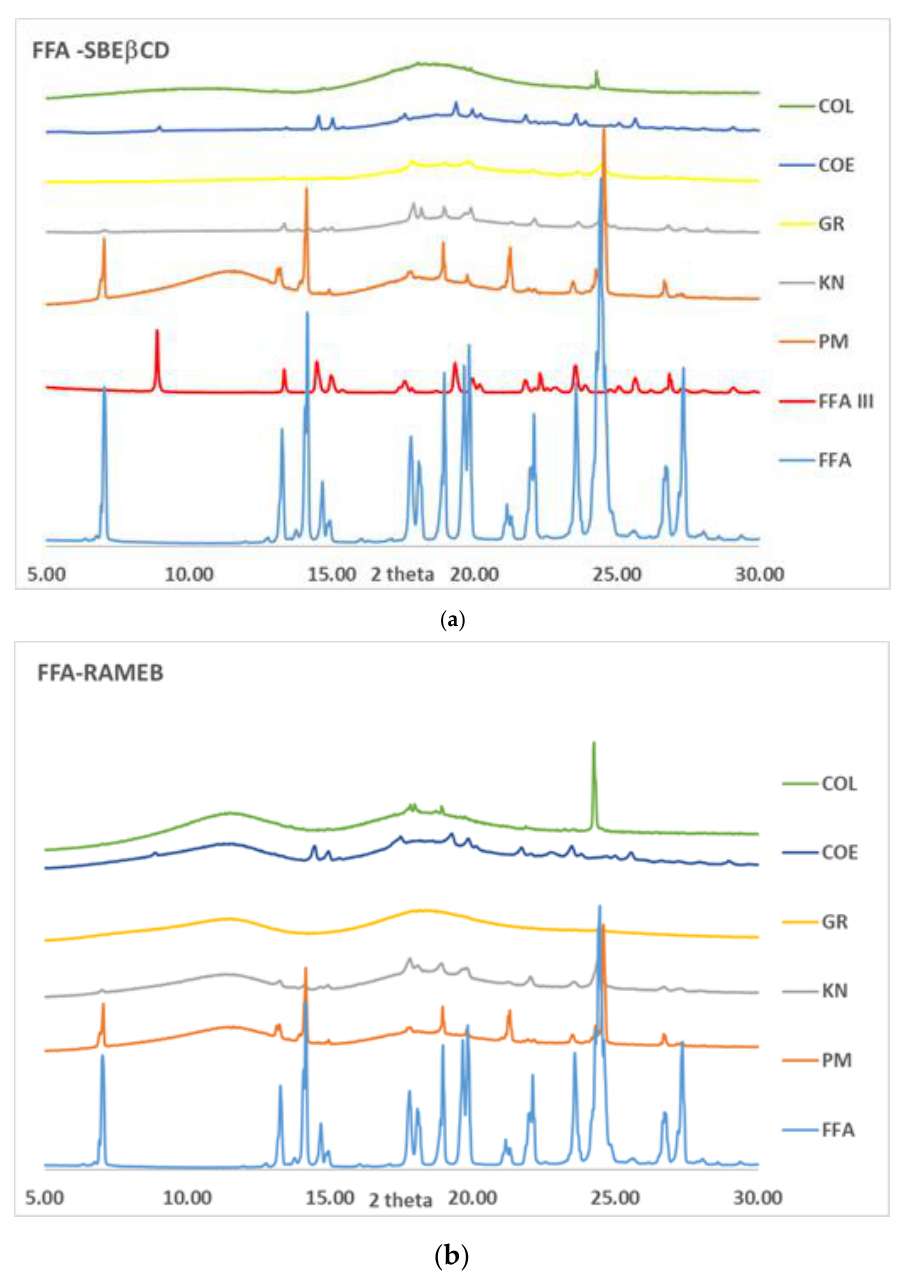
Figure 2. XRPD patterns of FFA binary systems with SBE β CD ( a ) and RAMEB ( b ) obtained by physical mixing (PM), kneading (KN), co-grinding (GR), co-evaporation (COE) and co-lyophilisation (COL).